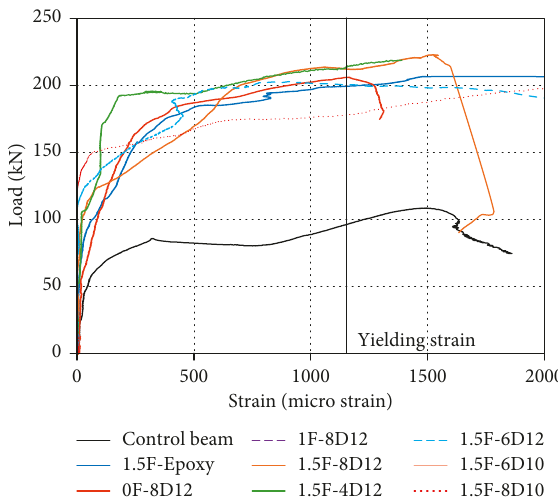
Figure 6: Load versus strain developed in the stirrups.